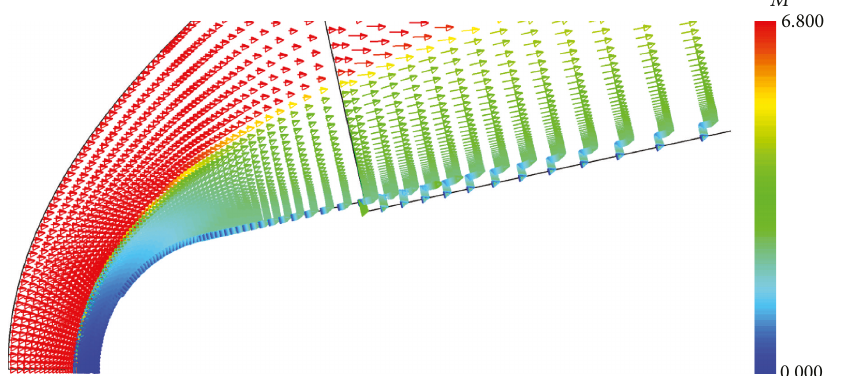
Figure 23: Tangent-slot velocity vectors, mass fl ow 0.55kg/S, Re = 4 3 × 10 6 , α = 0 0 ° , M = 6 8 .